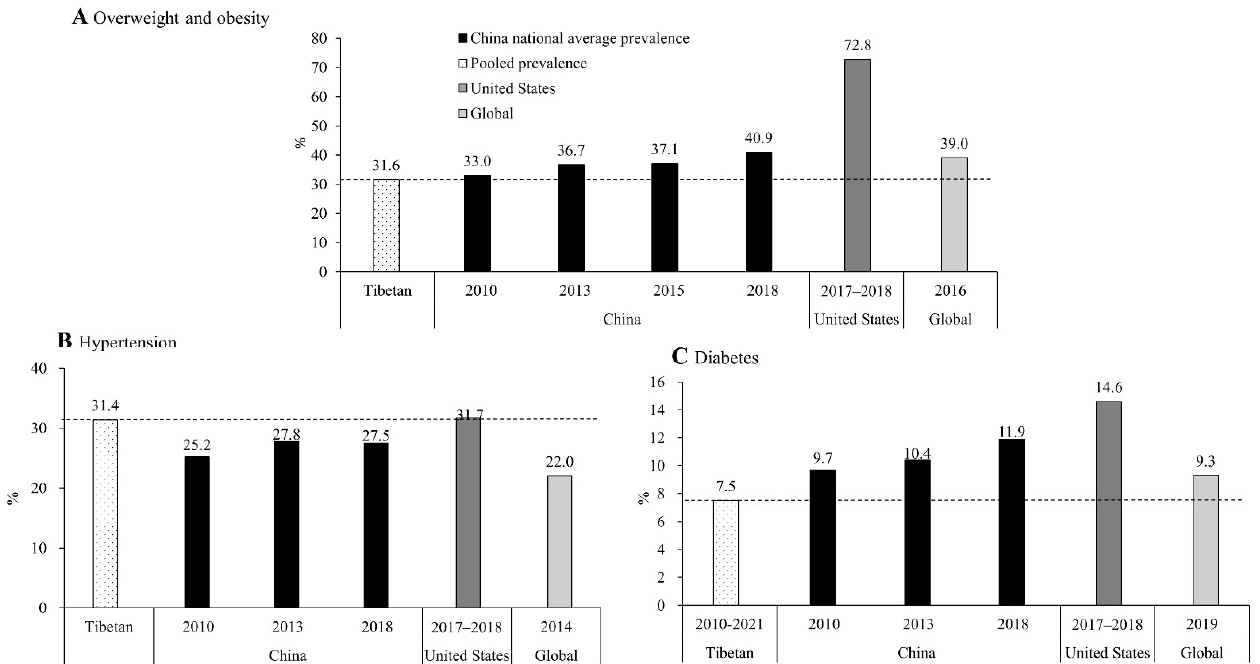
Figure 4. Comparison of combined prevalence of overweight/obesity, hypertension, and diabetes between Tibetan adults (≥18 years) and China, the United States, and the globe.